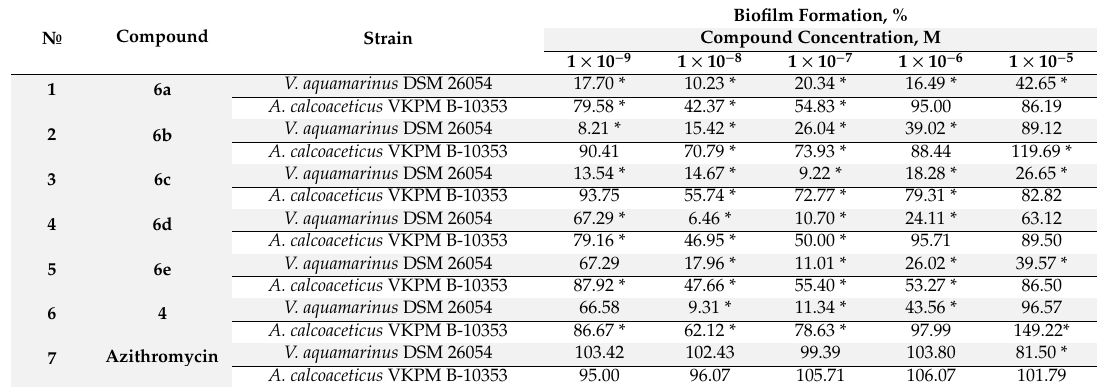
Table 5. Biofilm formation (%) by Vibrio aquamarinus DSM 26054 and Acinetobacter calcoaceticus VKPM B-10353 in the presence of pyrrolidine-1-carboxamides possessing benzofuroxan moiety in reference to control (control =